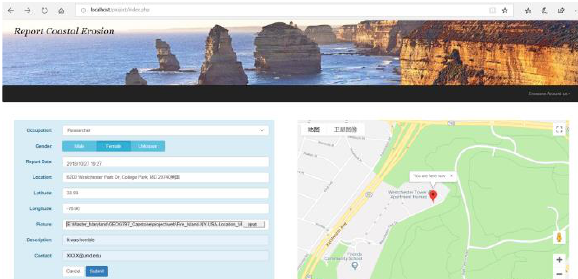
Figure 10. Website report page (Note: Screenshot from website)